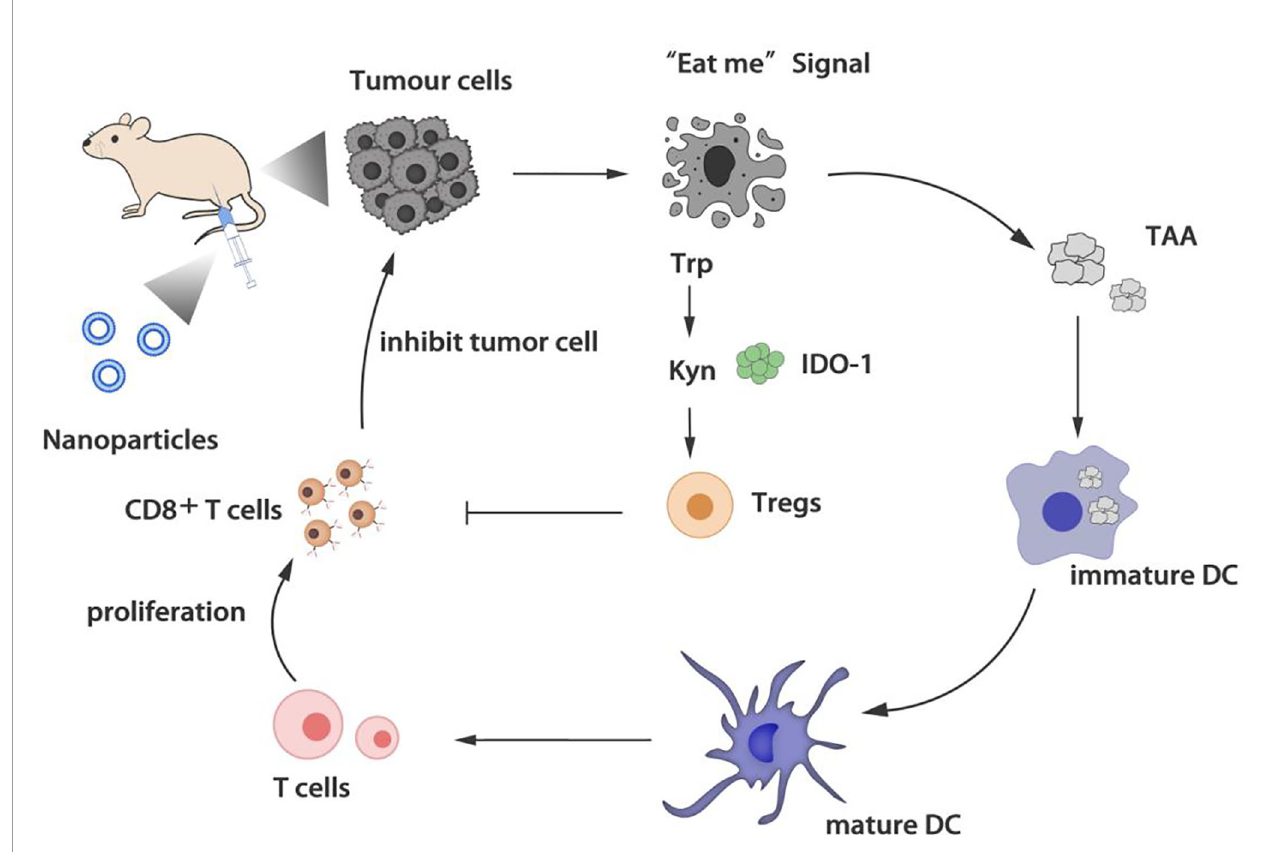
FIGURE 2 | Regulation of T